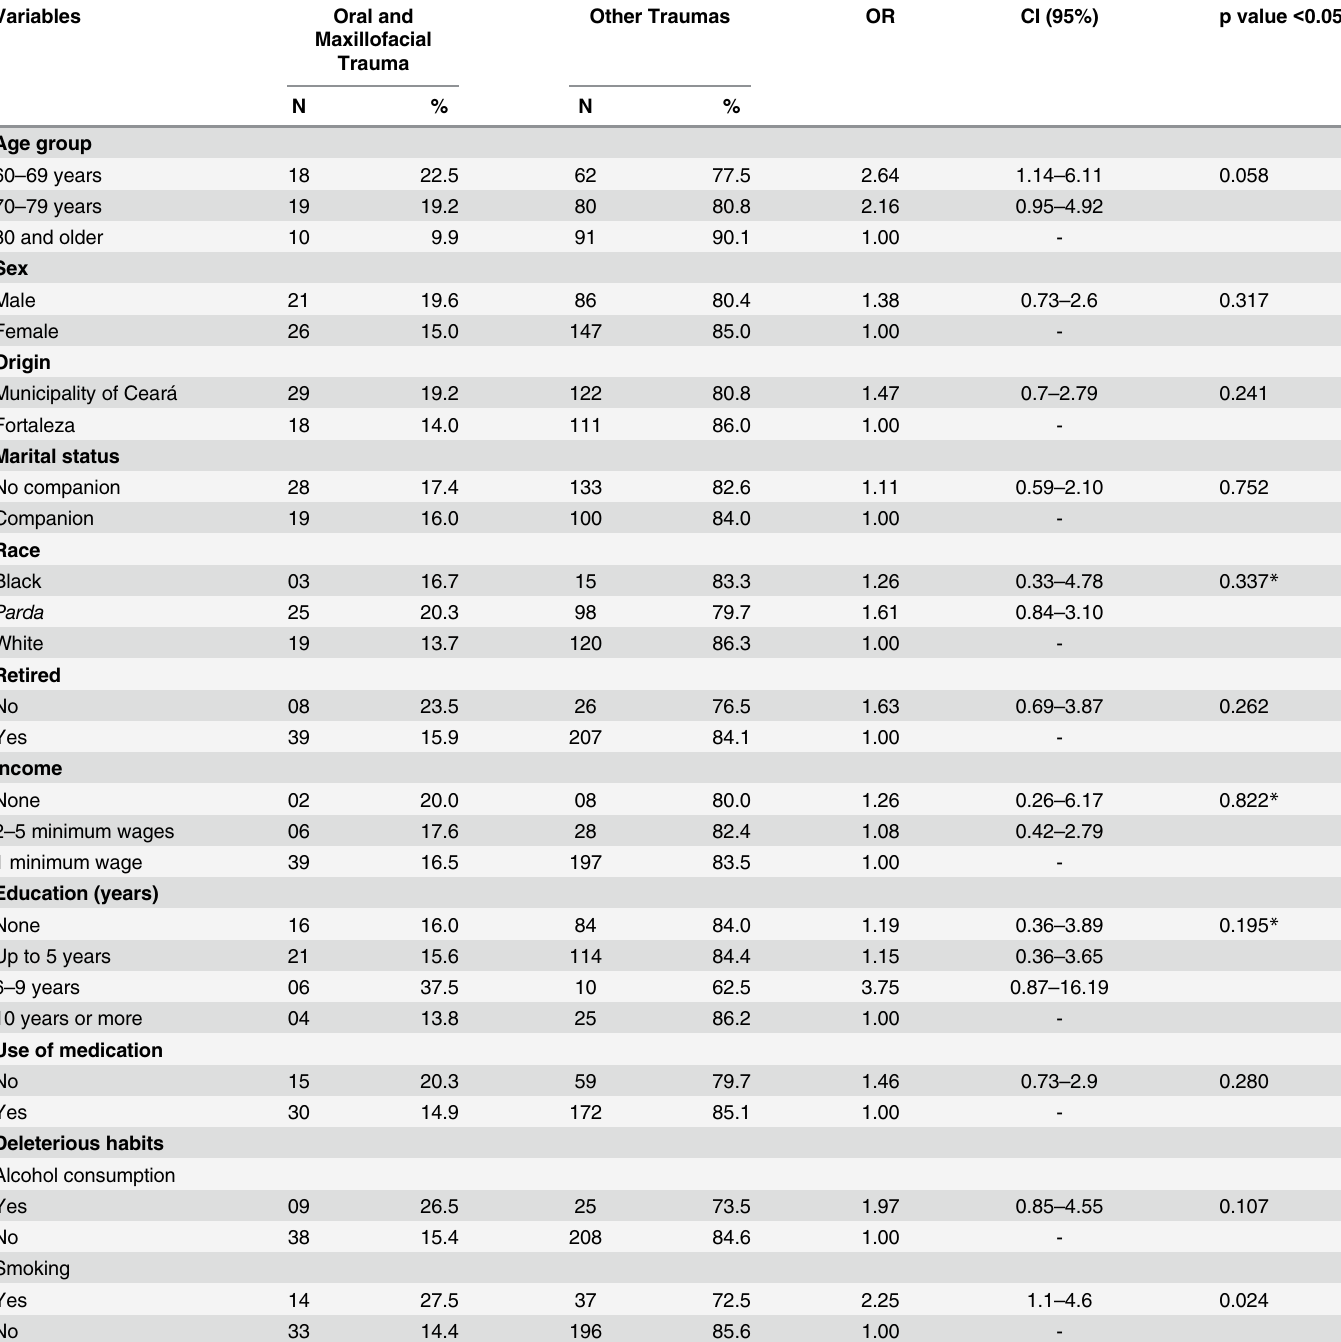
Table 1. Socio-demographic variables among elders with oral and maxillofacial trauma (n = 47) and other traumas (n = 233). Fortaleza-Ceará, 2014.